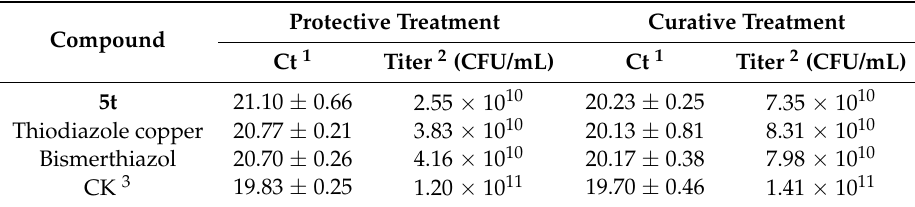
Table 8. The Xoc titer in the rice leaves treated by compound 5t .